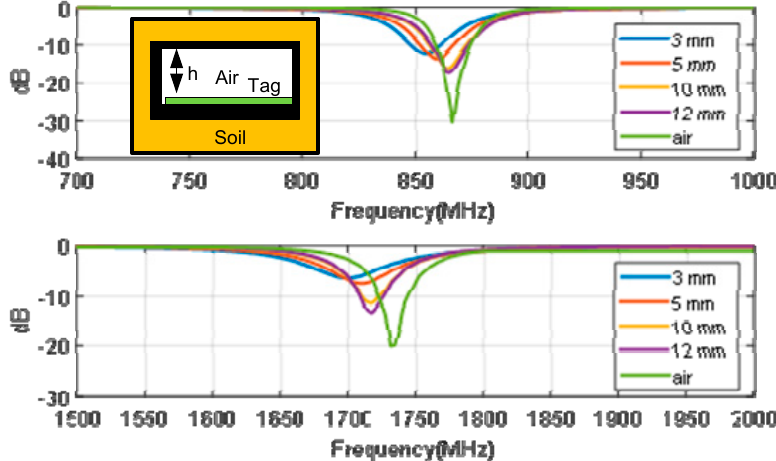
Figure 5. Reflection coefficient of the patch antenna at the fundamental frequency ( top ) and the second harmonic ( bottom ) as a function of frequency for different spacer thickness (h = 3 mm, 5 mm, 10 mm, 12 mm, and the tag in the air). The inset figure shows a schema of the cross-section of the box in the soil.